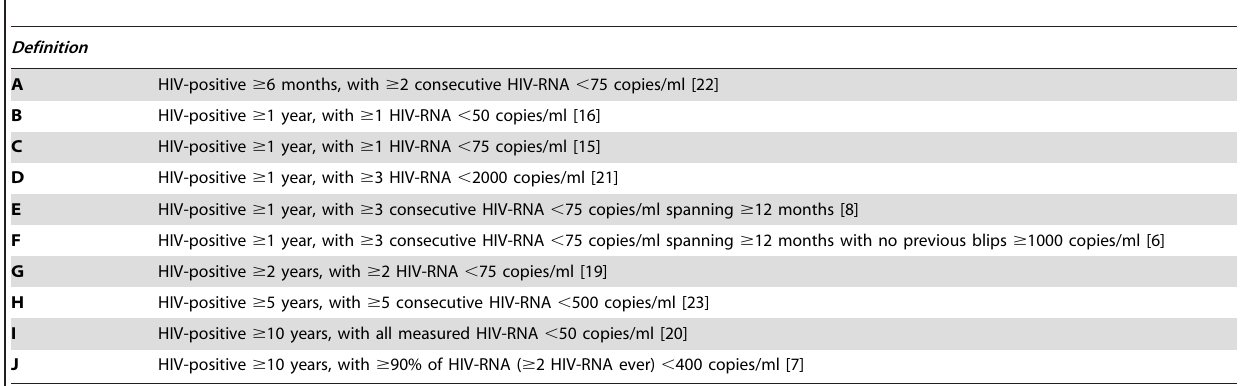
Table 1. 10 definitions of elite control from the literature applied to the CASCADE dataset; all require individuals to be AIDS-free and